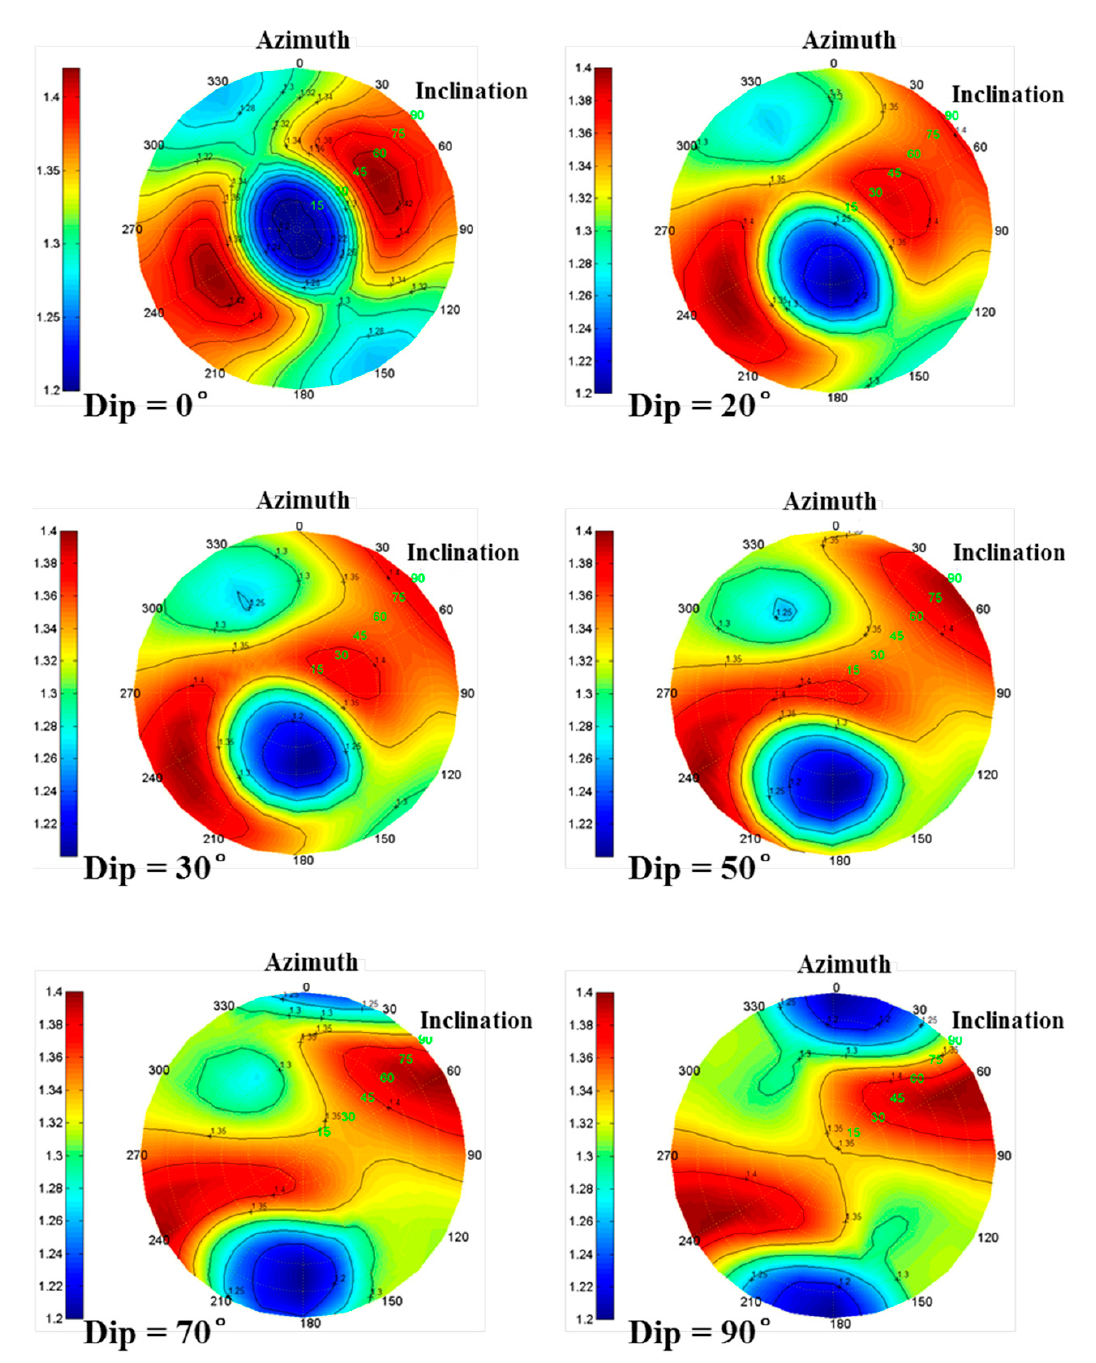
Figure 10. Collapse pressure for different inclinations and azimuths of borehole and dip angles of bedding planes (dip direction of bedding plane is at 15°; direction of the minimum horizontal stress is at 60°).